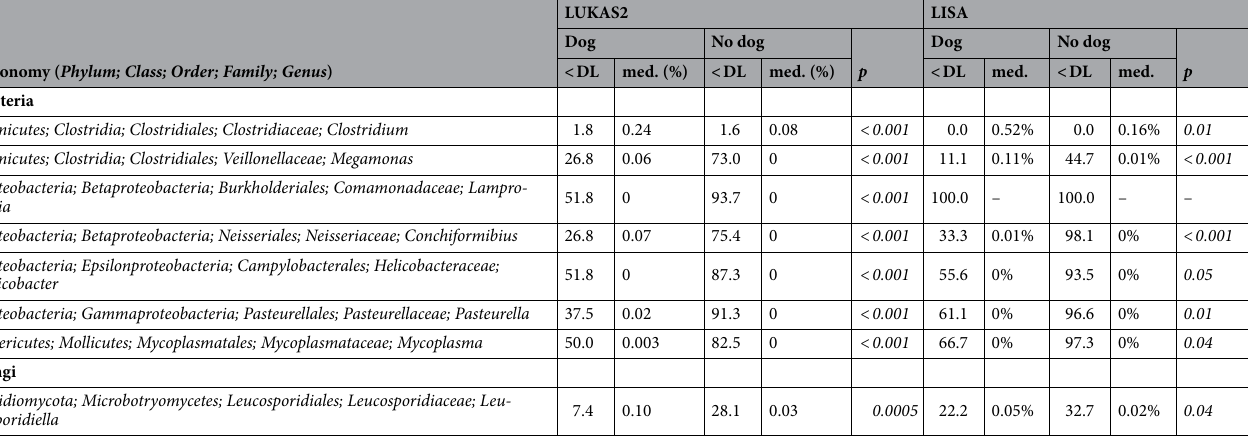
Table 1. Comparisons between relative abundances of seven bacterial and one fungal genera in households with or without dog in LUKAS2 and LISA birth cohort studies. < DL percentage of samples under detection limit; med. median relative abundance; – not found in LISA. The number of dog homes (the number of no dog homes) in bacterial data in LUKAS2 and LISA: 56 (126) and 18 (262). The number of dog homes (the number of no dog homes) in fungal data in LUKAS2 and LISA: 54 (121) and 18 (257). p -values are from Mann– Whitney U-test in LUKAS2 and weighted Mann–Whitney U-test in